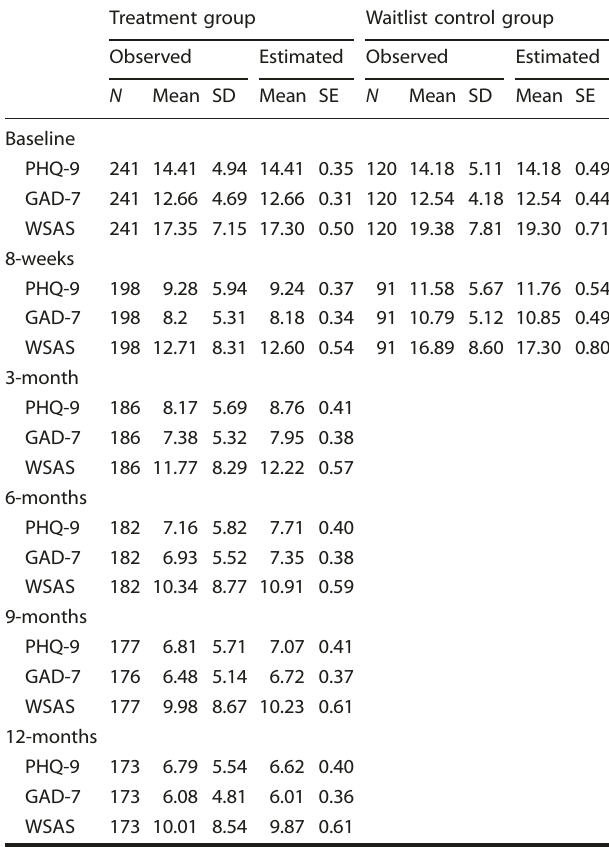
Fig. 2 Estimated marginal means and con fi dence intervals (CI) for time by treatment group interaction effects at 8-weeks. a Random intercept linear mixed model suggesting signi fi cant time by intervention-arm interaction effect. Bonferroni adjusted estimated mean difference between intervention-arms at 8-weeks 2.52 (95% CI 0.78, 4.27, p = 0.0009). Between group effect size d = 0.55 (95% CI 0.32, 0.77). b Random intercept linear mixed model suggesting signi fi cant time by intervention-arm interaction effect. Bonferroni adjusted estimated mean difference between intervention-arms at 8-weeks 2.67 (95% CI 1.07, 4.26, p = 0.0001). Between group effect size d = 0.63 (95% CI 0.40, 0.85). c Random intercept linear mixed model suggesting signi fi cant time by intervention-arm interaction effect. Bonferroni adjusted estimated mean difference between intervention-arms at 8-weeks 4.68 (95% CI 2.11, 7.24, p < 0.0001). Between group effect size d = 0.35 (95% CI 0.13, 0.57). Table 2. Observed and estimated marginal means across time-points and by treatment